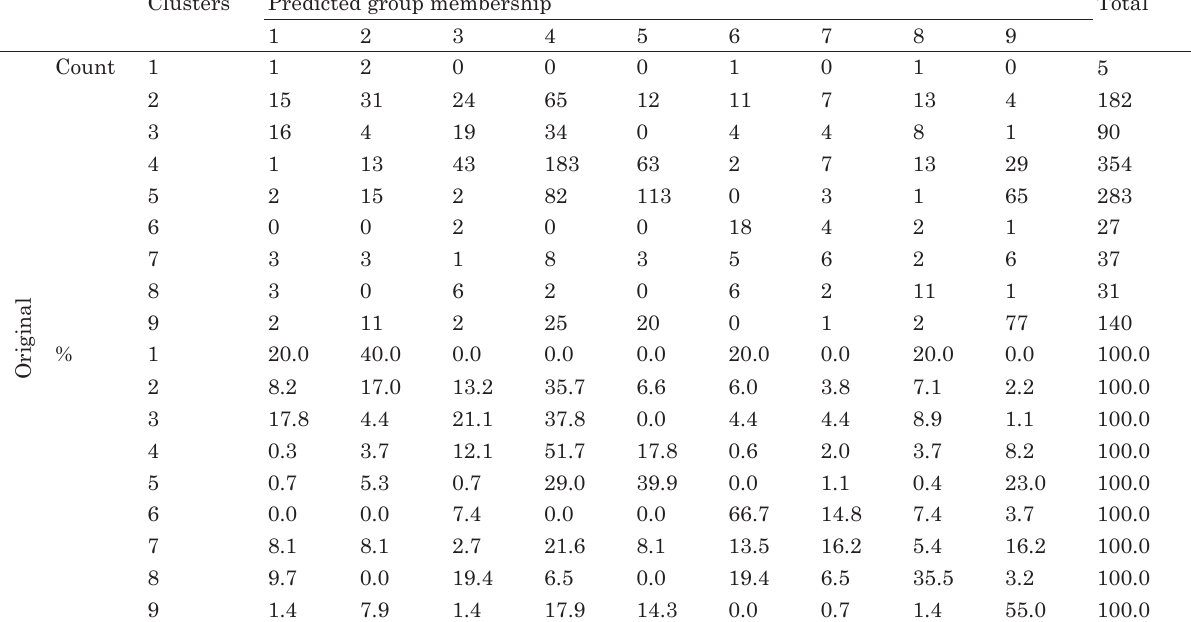
Table 7. Classification